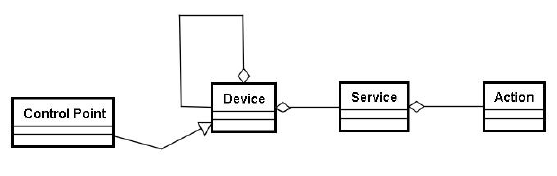
Figure 4. Service model of